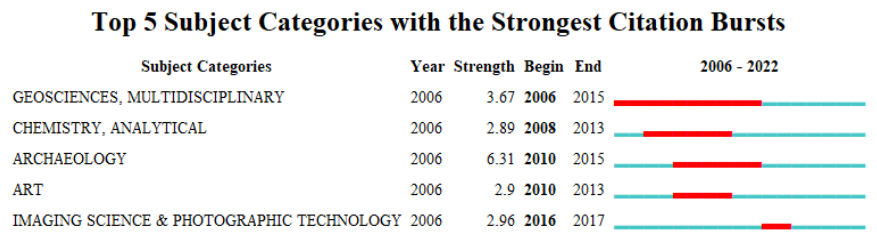
Figure 10. The top five subject categories with the strongest citation bursts.